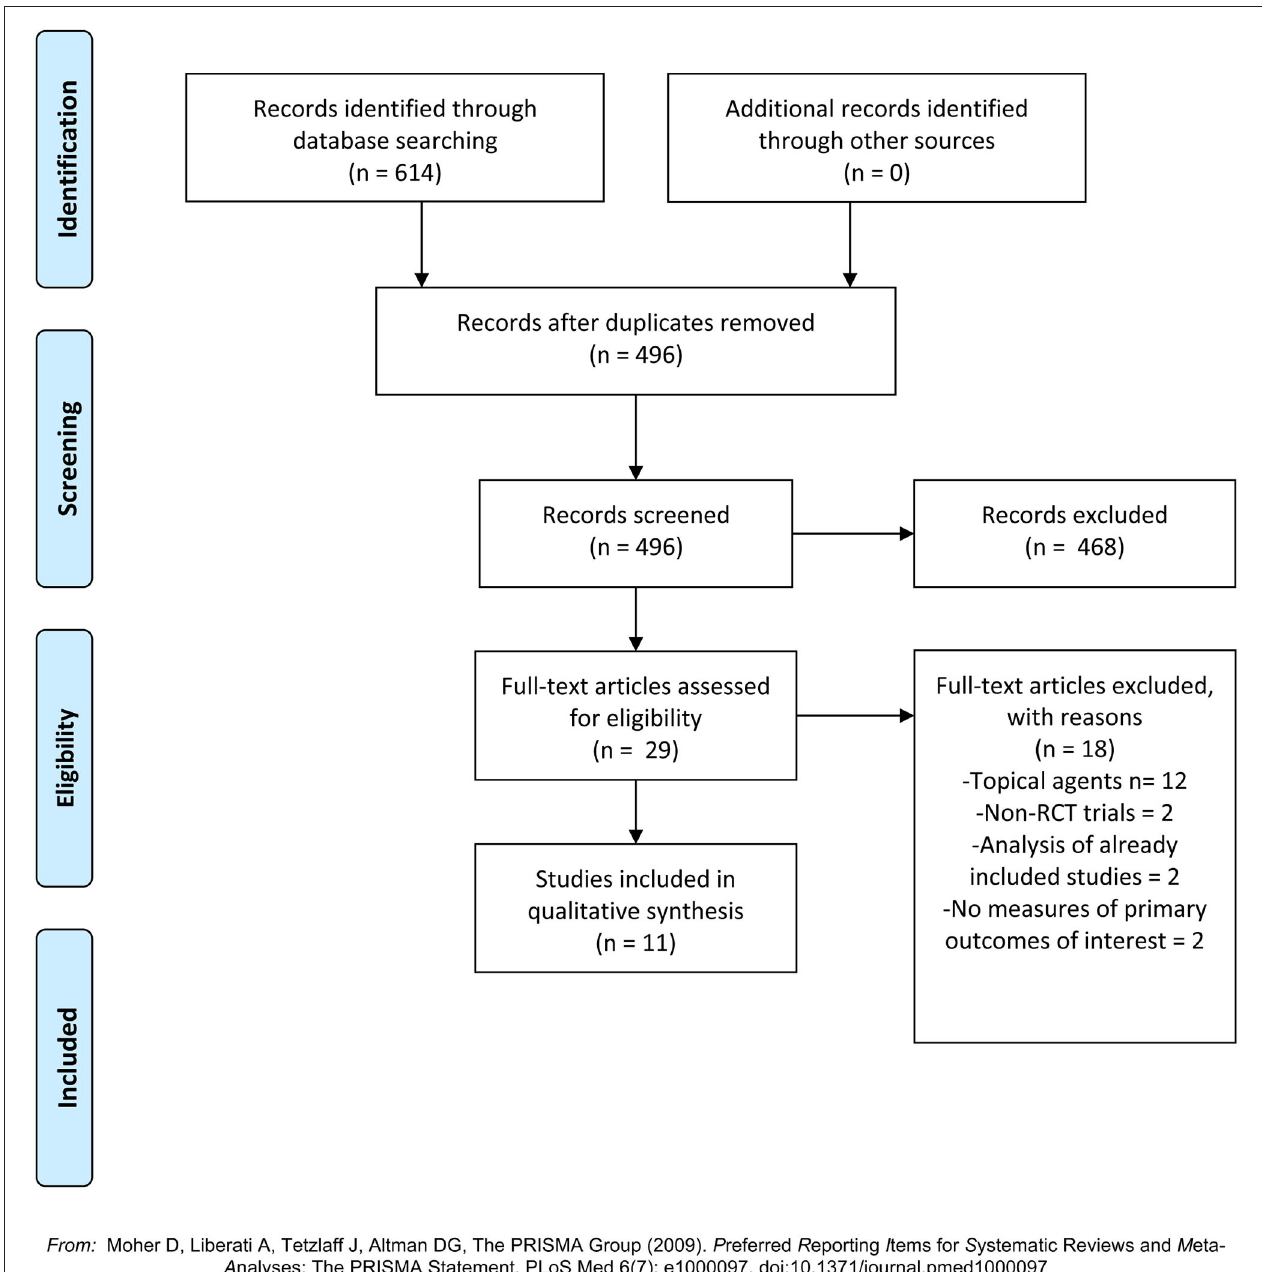
FIGURE 2 | PRISMA Flow